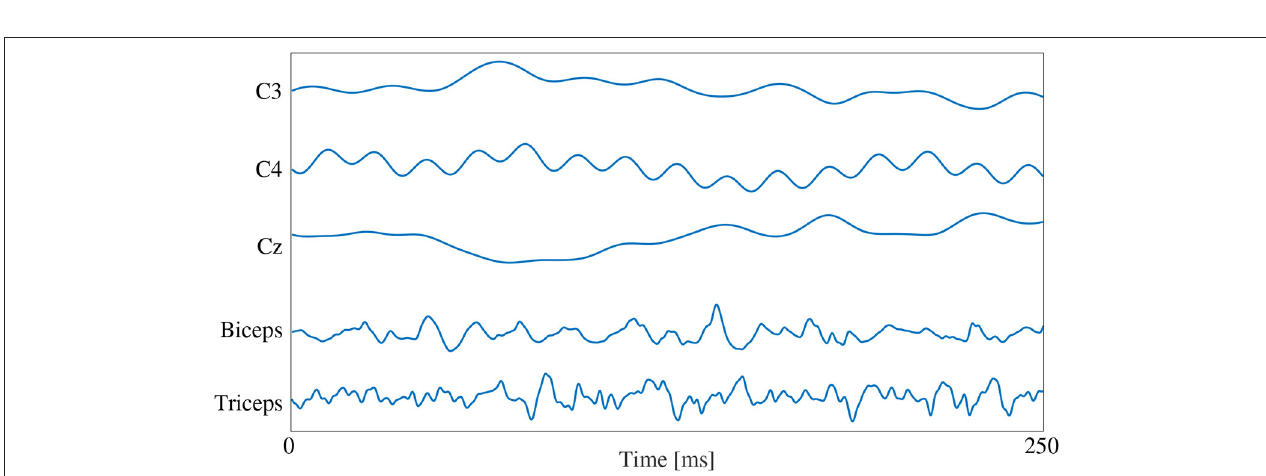
FIGURE 3 | A graphical representation of a sample normalized signal image. The image height contains 5 rows, one for each signal channel, and the image width is dictated by the number of samples in each 250 ms window (1,000 samples at the 4,000 Hz sampling rate).